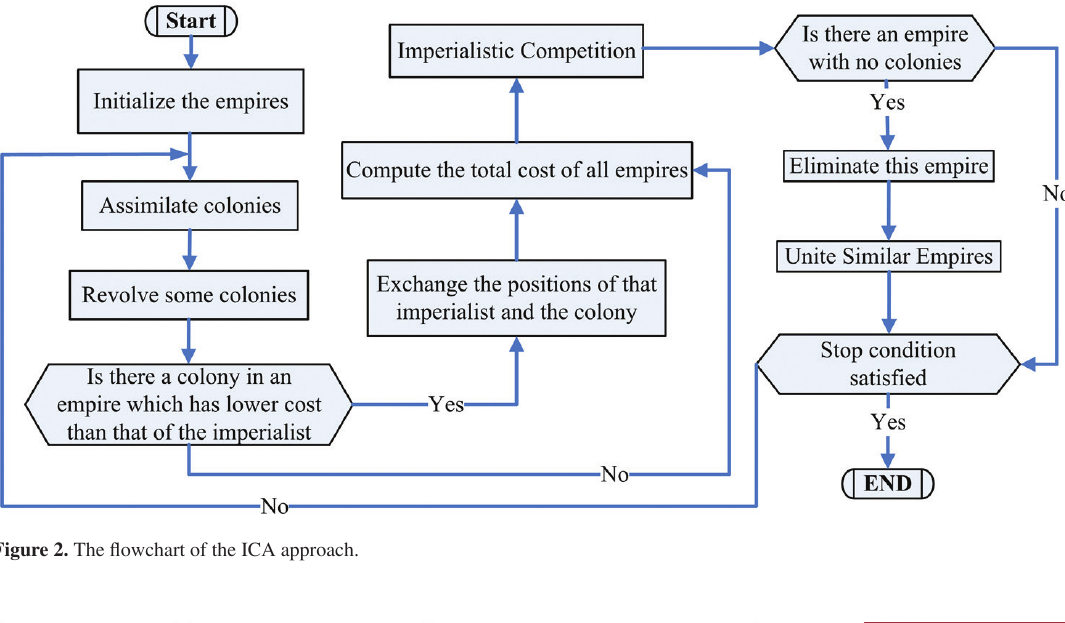
Figure 2. The flowchart of the ICA approach.